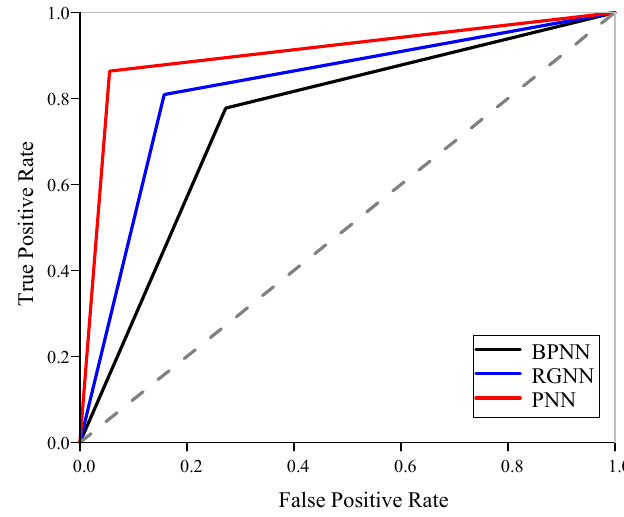
Figure 11. Comparison of ROC curves of different classifiers.